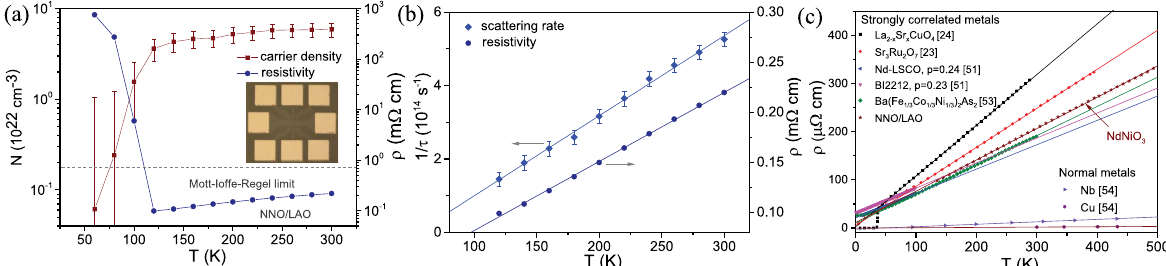
Fig. 5 Strange metal-like T -linear resistivity. a Log of carrier density and log of resistivity of a 5 nm NNO/LAO fi lm as a function of temperature. The inset shows the Hall bar used, with channel dimensions 620 × 100 μ m 2 . The dashed line indicates the Mott – Ioffe – Regel limit in nickelates 22,29 . b 1/ τ as a function of temperature is plotted together with the resistivity and their linear fi ts. c The T -linear resistivities of reported Planckian metals 23,24,51,53,54 together with that of the NNO/LAO fi lm. In a and b , error bars indicate the statistical